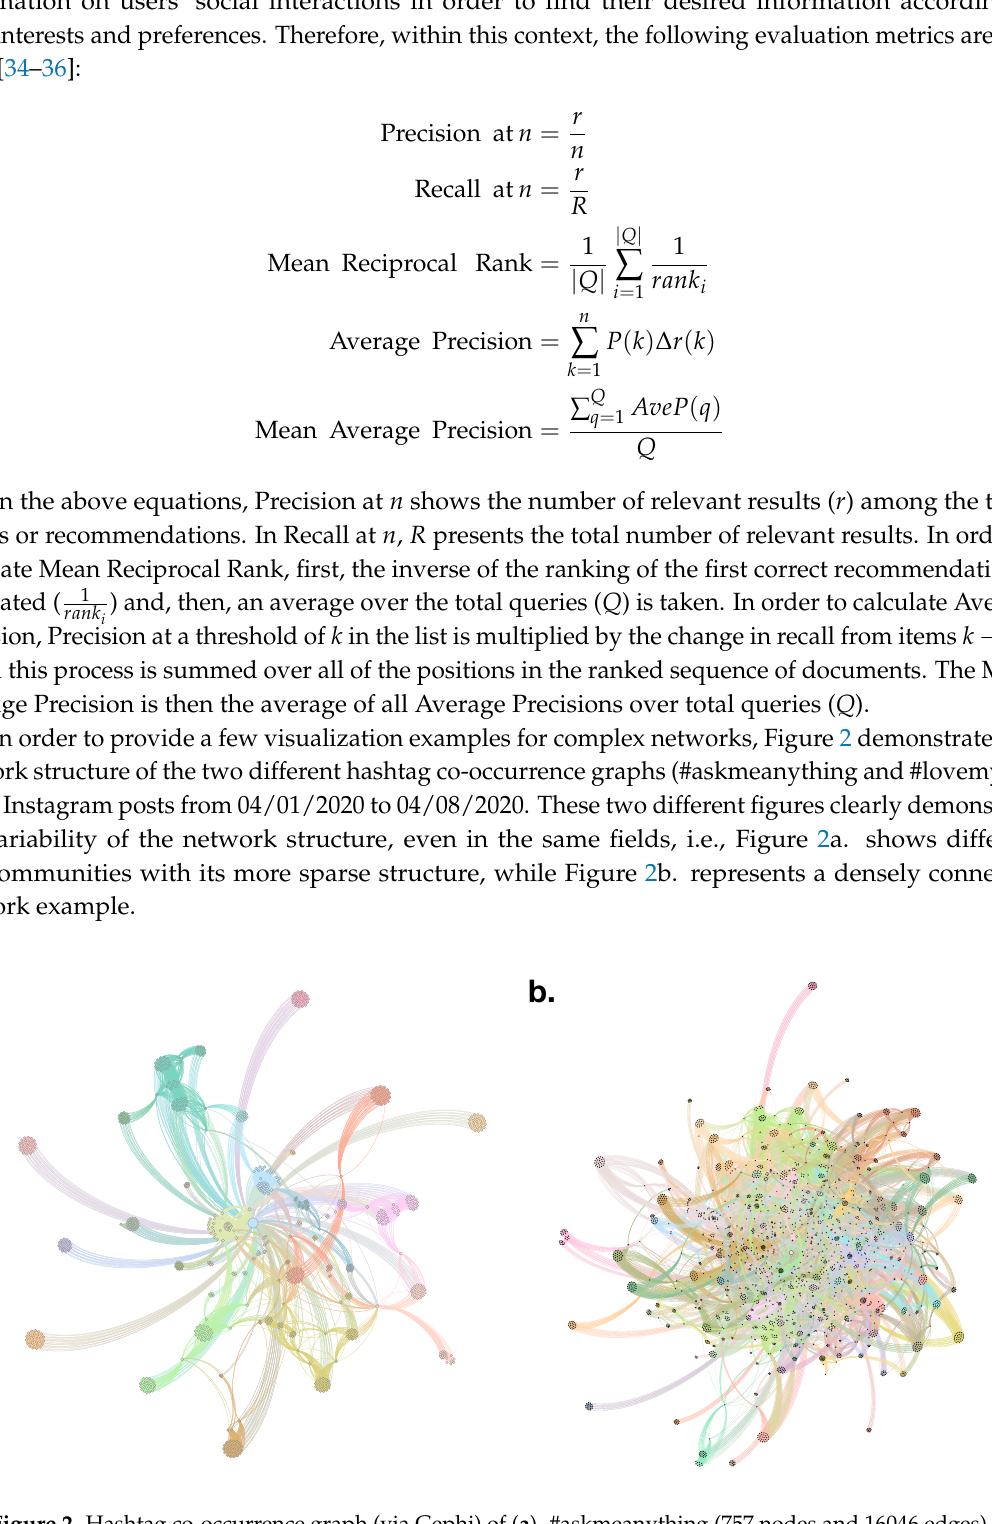
Figure 2. Hashtag co-occurrence graph (via Gephi) of ( a ). #askmeanything (757 nodes and 16046 edges), ( b ). #lovemylife (2748 nodes and 63413 edges). Each network is colored by the modularity